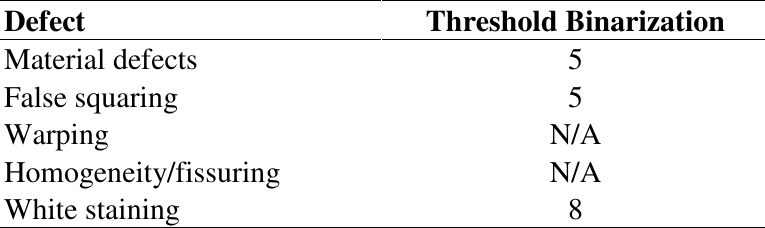
Table 2. Defects and threshold binarization.